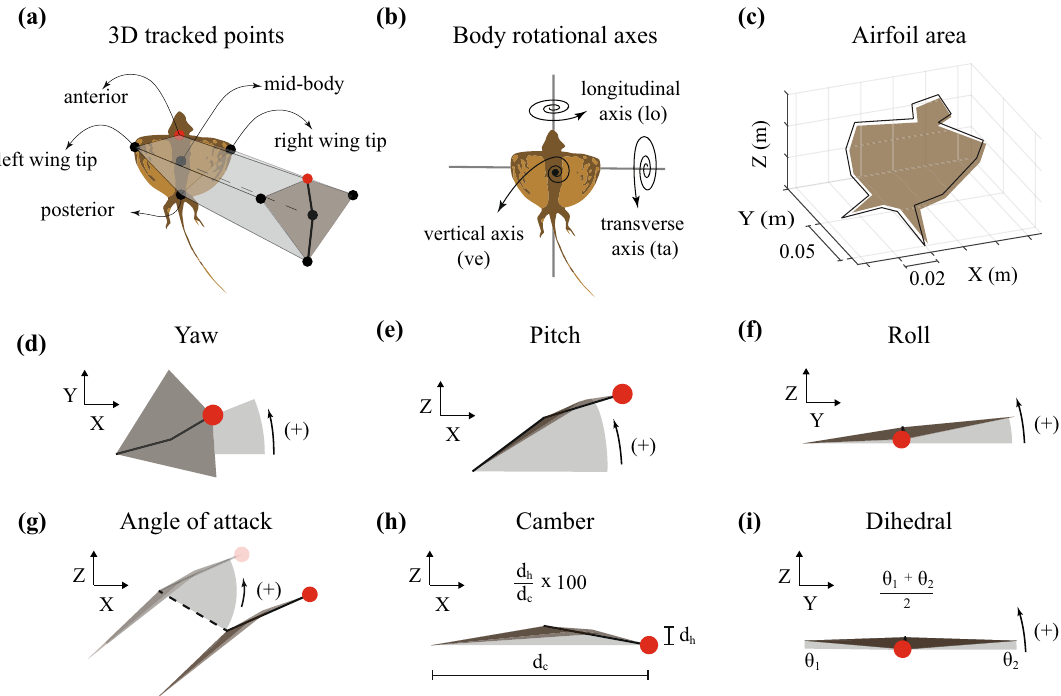
Figure 2. An illustration of the tracked body points and the metrics calculated for each glide. ( a ) Illustration showing the five body points tracked per frame for each glide. ( b ) The three axes about which the lizard can reorient in flight. Longitudinal axis ( lo ) about which the lizard rolls. Transverse axis ( ta ) about which the lizard changes pitch. Vertical axis ( ve ) about which the lizard changes yaw. ( c ) Illustration showing the airfoil area used to calculate the aerodynamic force coefficients. The area was calculated by fitting a plane to the 17 3D points tracked around the lizard in a single frame during the glide when the patagium was completely stretched open. ( d ) Yaw angle is the rotation about the ( ve ) from the X–Z plane, positive yaw is to the lizard’s left. ( e ) Pitch angle is the rotation about the ( ta ) from the X–Y plane, positive pitch raises the head upward. ( f ) Roll angle is the rotation about the ( lo ) from the Z–Y plane, positive roll raises the left-wing tip. ( g ) Angle of attack (AoA) is the angle made by the airfoil surface relative to the direction of motion (airflow), positive AoA is counterclockwise. ( h ) Camber is the convexity (concave down) of the airfoil from the leading to the trailing edge. The formula provided shows the calculation for % camber. ( i ) Dihedral angle is the average of the upward angle made by either side of the wing with the X–Y